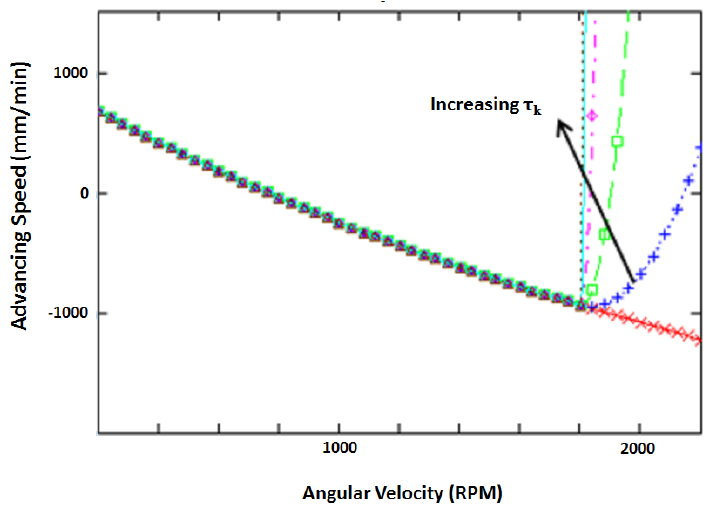
Figure 9. Graphical representation of penalty